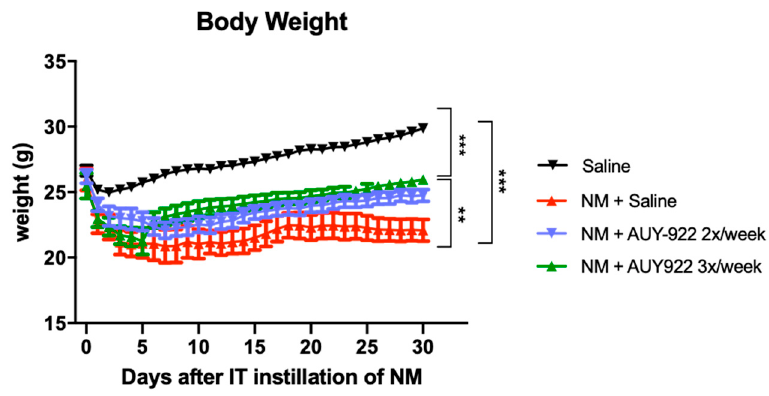
Figure 1. Body weight changes in mice after intratracheal instillation of 0.625 mg / kg nitrogen mustard (NM) or saline and treatment with AUY-922; ***: p < 0.001, **: p < 0.01 with ANOVA and Turkey’s. n = 6 mice per group.